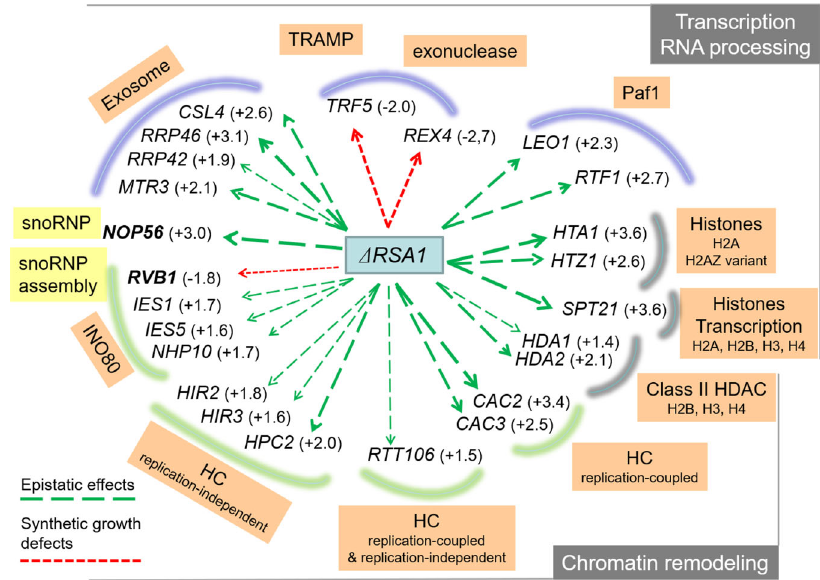
Fig. 1 Data from the GIM screen. Two independent screens were performed, one with a mutant strain in which the RSA1 gene was deleted ( rsa1 Δ ::Nat R ) and the other with a mutant used as reference strain. Two independent experiments were performed for each of these screens. The query strain and the reference strain were mated with a pool of strains containing all the viable strains from the haploid gene deletion collection. After selection of heterozygous diploids, sporulation and selection of the haploid, double mutants were grown for ~18 generations in rich liquid medium (YPD). Microarrays were used to measure the relative abundance of double mutants with query versus the reference populations. Normalized results are expressed as log2(Q/R) (see Methods section). Negative values indicate a synthetic growth defect. Positive values reveal either epistatic (buffering) or suppressive (alleviating) interactions between RSA1 and the selected genes. The genetic interactions with RSA1 are indicated by green arrows for the positive log2(Q/R) values and by red arrows for the negative values. The exact values are given in parentheses. HC